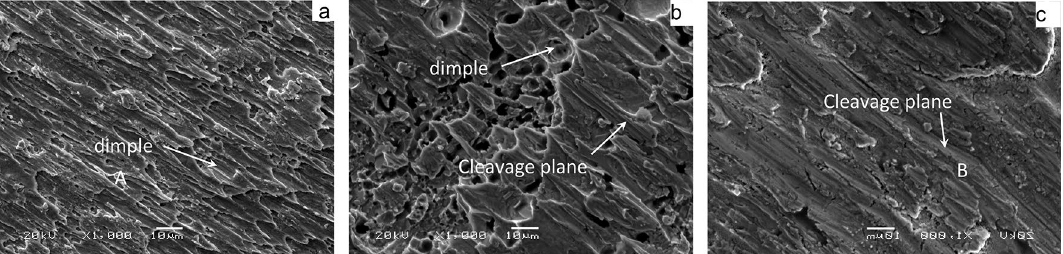
Figure 13. Shear-fractured morphology of Sn2.5Ag0.7Cu0.1RE0.1Ni/Cu solder joints after 0, 300, 1000 thermal cycles ( a ) 0cycles, ( b ) 300cycles, ( c ) 1000